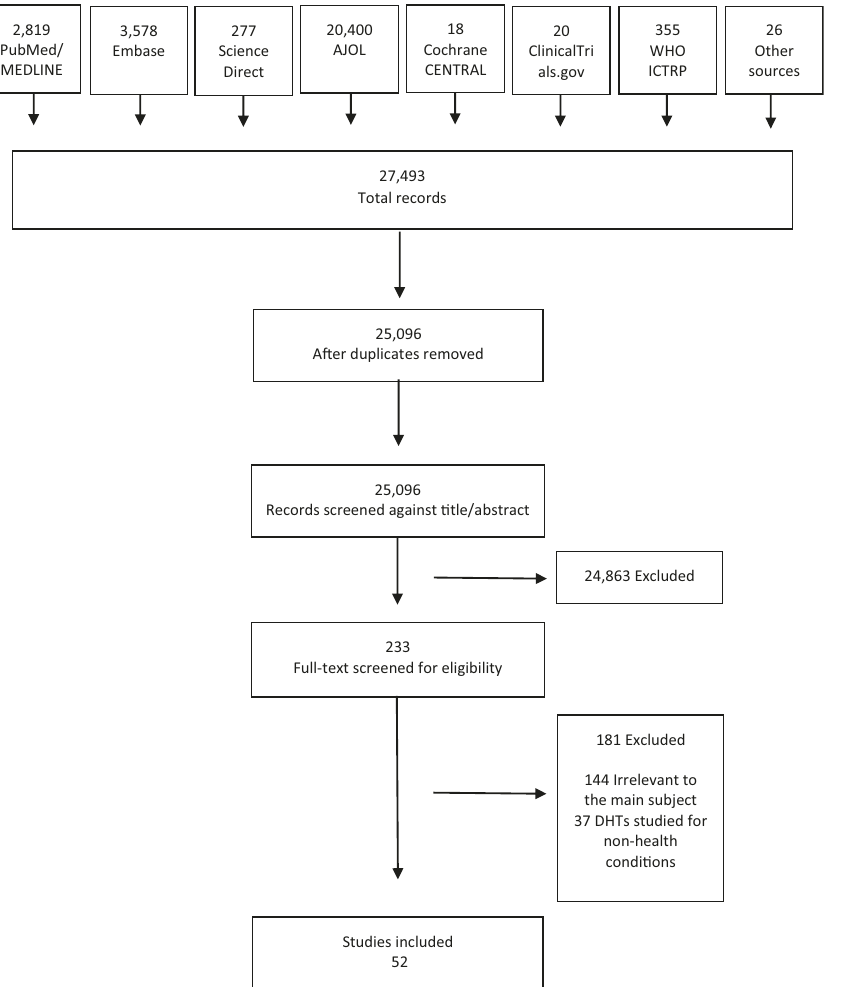
Fig. 1 PRISMA fl ow diagram of the study. PRISMA (preferred reporting items for systematic reviews and meta-analyses) fl ow diagram of included